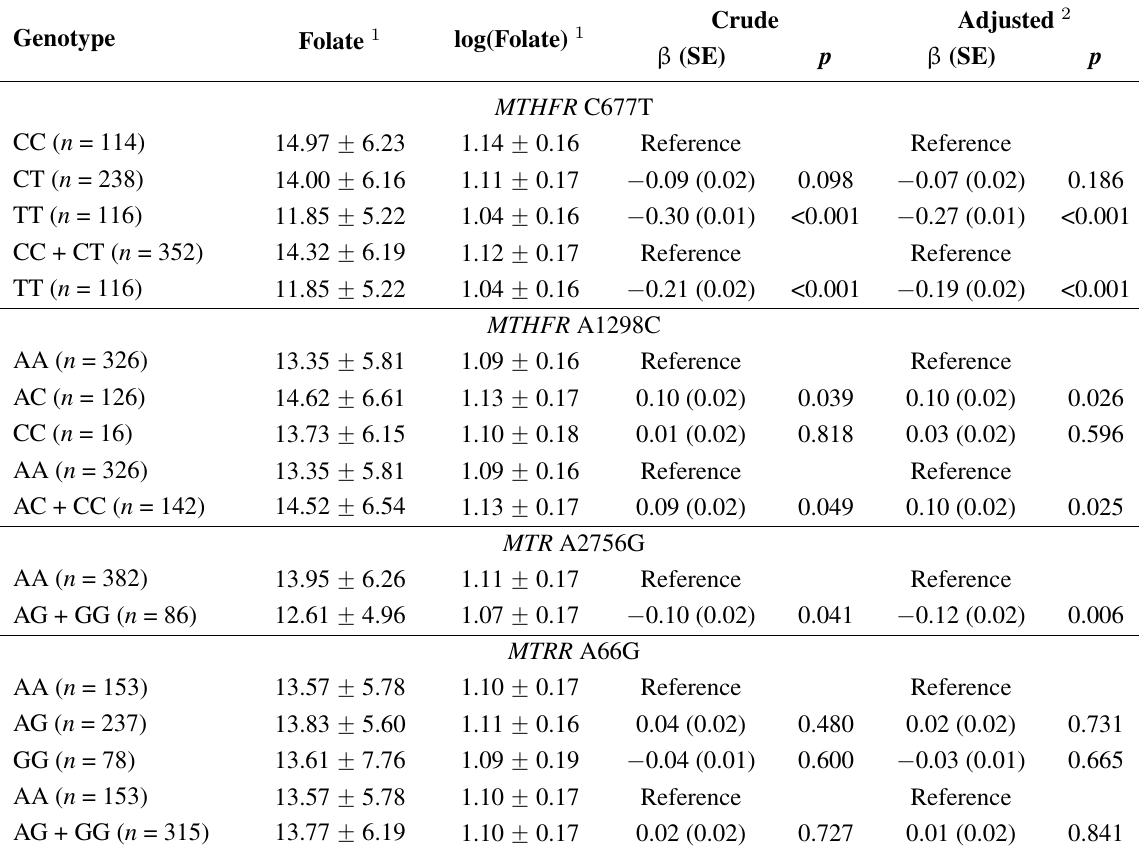
Table 3. Associations of gene polymorphisms with serum folate